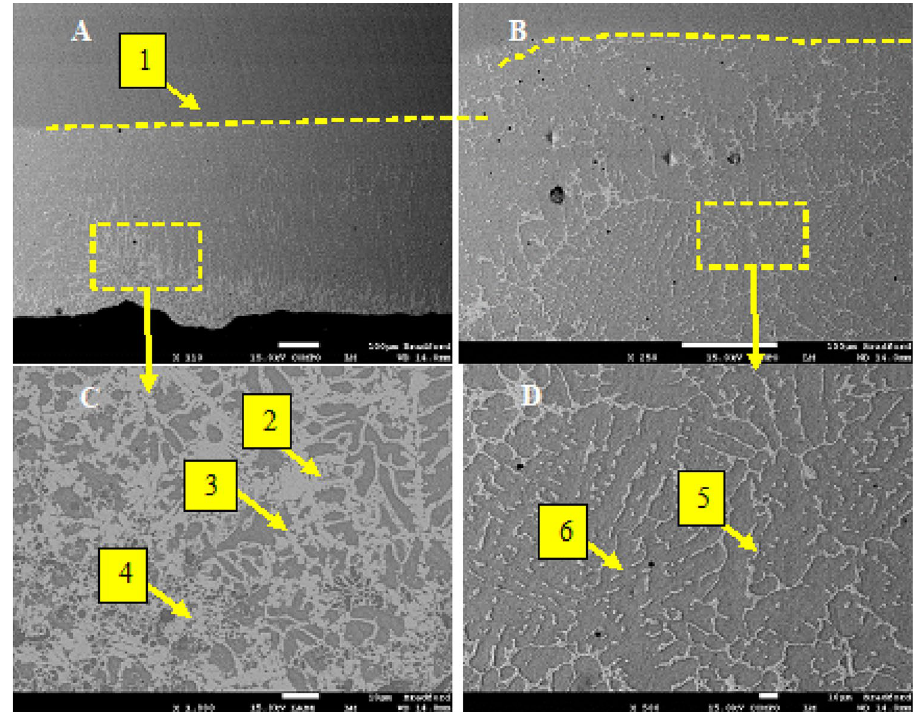
Figure 3. ( A ) The treated surface of the Ti-6Al-4V alloy 250 nm TiO 2 and 40 nm Al 2 O 3 ( B ) highlighted section of the treated layer ( C ) microstructure showing three distinct phases ( D ) Highlighted section of the treated zone showing the presence of large dark region labelled as 6 with the composition of τ 1 = Al 13 Ni 2 Ti 5 (Al 64 Ni 10 Ti 26 ), and light colour region labelled as "5" which is likely of the composition τ2 = = Al 2 NiTi (Al 55 Ni 23.5 Ti 21.4